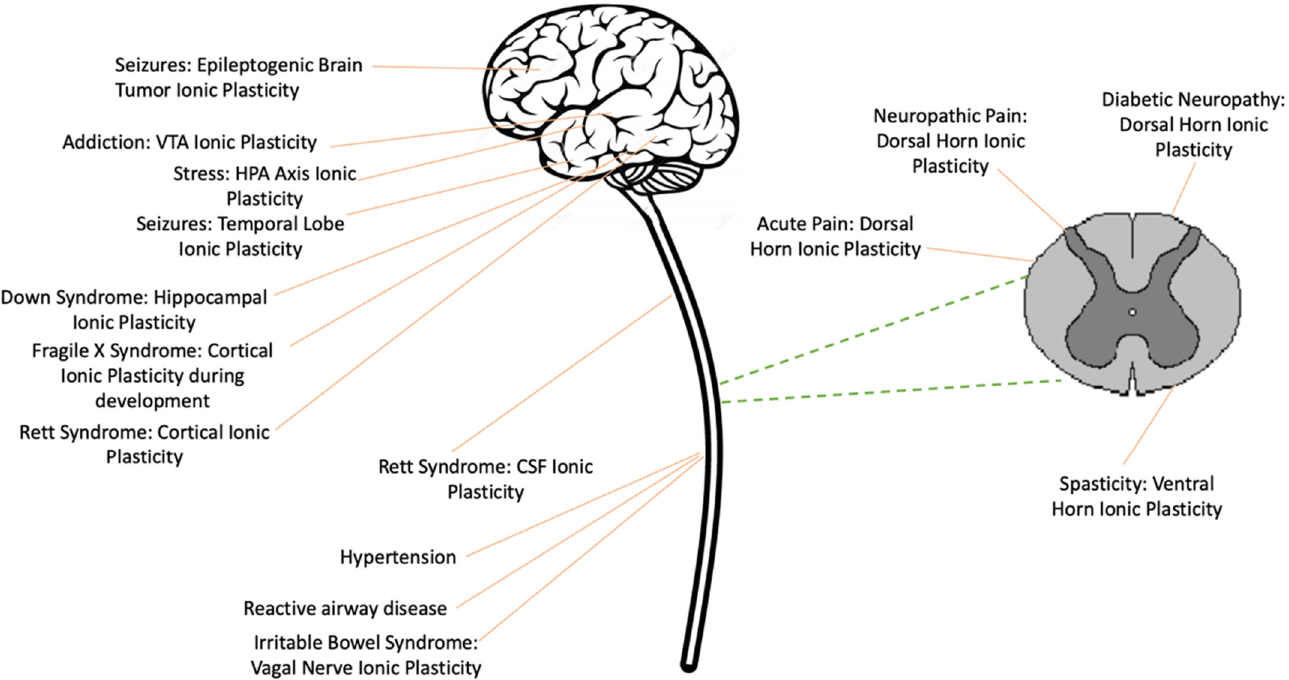
Figure 1. Ionic plasticity along the neural axis. A pictorial representation of the neural axis indi- cating the locations of identified ionic plasticity covered in this review and the associated neural disease states.